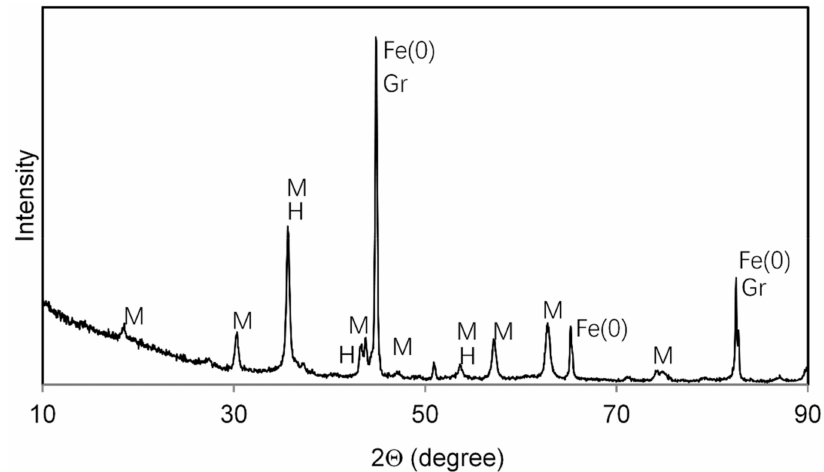
Figure 2. X-ray Di ff raction (XRD) pattern of BC-Mag particles synthesized at 1000 ◦ C. M = magnetite, H = hematite, Fe(0) = iron metal (alpha form), Gr =